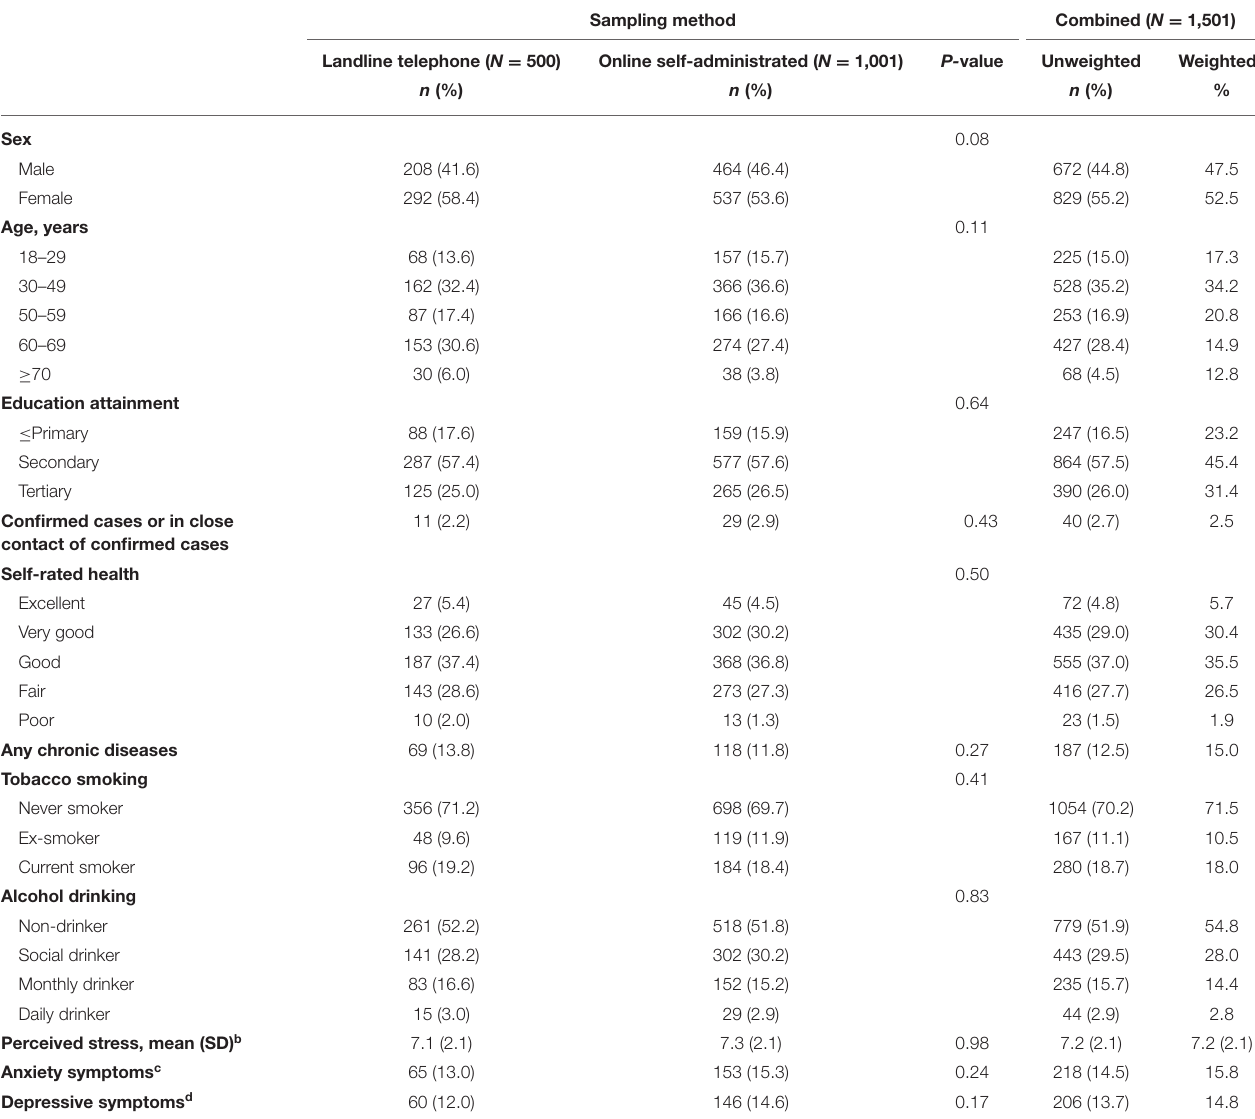
TABLE 1 | Sociodemographic characteristics and health status by sampling